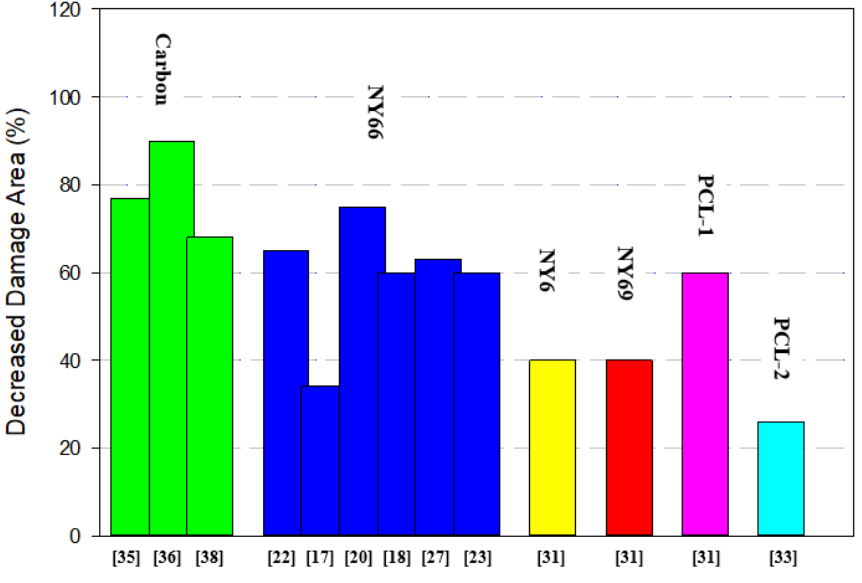
Figure 9. Decreased damage parameter caused by various nanofibers.